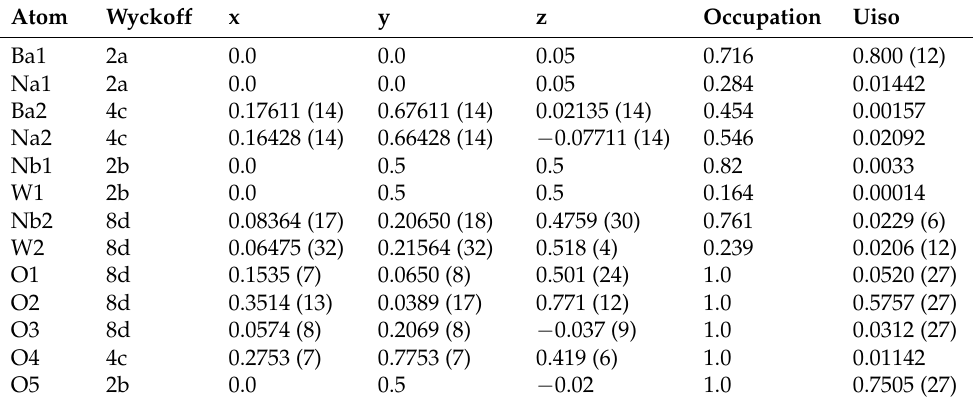
Table 2. Refined atom positions of the crystalline phase Ba 0.54 Na 0.46 Nb 1.29 W 0.37 O 5 .